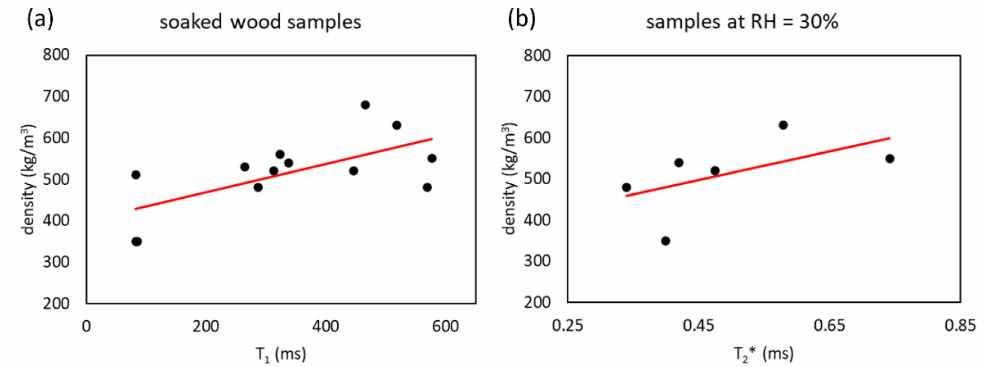
Figure 5. Linear correlations between ( a ) Water relaxation time T 1 and wood density; ( b ) water relaxation time T 2 * and wood